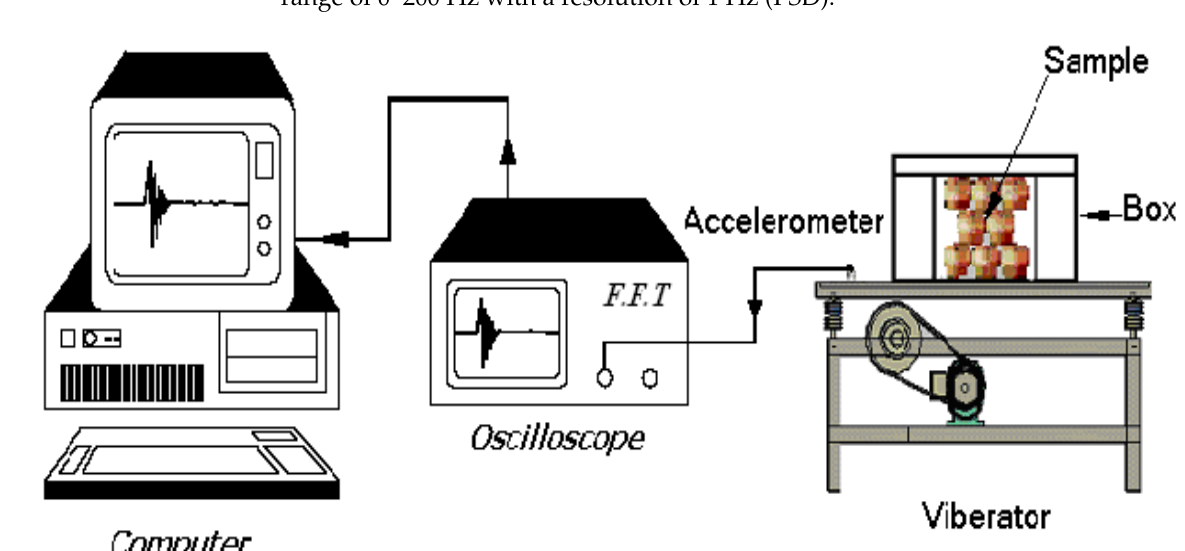
Figure 4. Schematic layout of the system used for the vibration analysis.